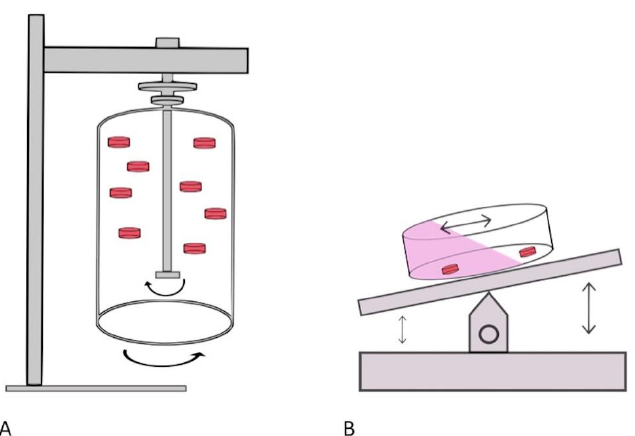
Figure 3. Dynamic physiological culture techniques that utilises a rotational bioreactor to replicate physiological flow dynamics. ( A ) An illustration of one method whereby tissue is suspended in culture medium due to concurrent rotation of both inner rotating cylinder and outer vessel wall. As a consequence, the tissues (illustrated by the red cylinders) are maintained in a state of continuous free fall with minimal shear stress exerted on them; ( B ) an illustration of how a rocking platform bioreactor enables dynamic culture. The serial rocking movement permits the flow of media (illustrated in pink within the figure) over the cultured tissue. The preexisting culture media is redistributed across the culturing vessel. How- ever, there is no automated renewal of the